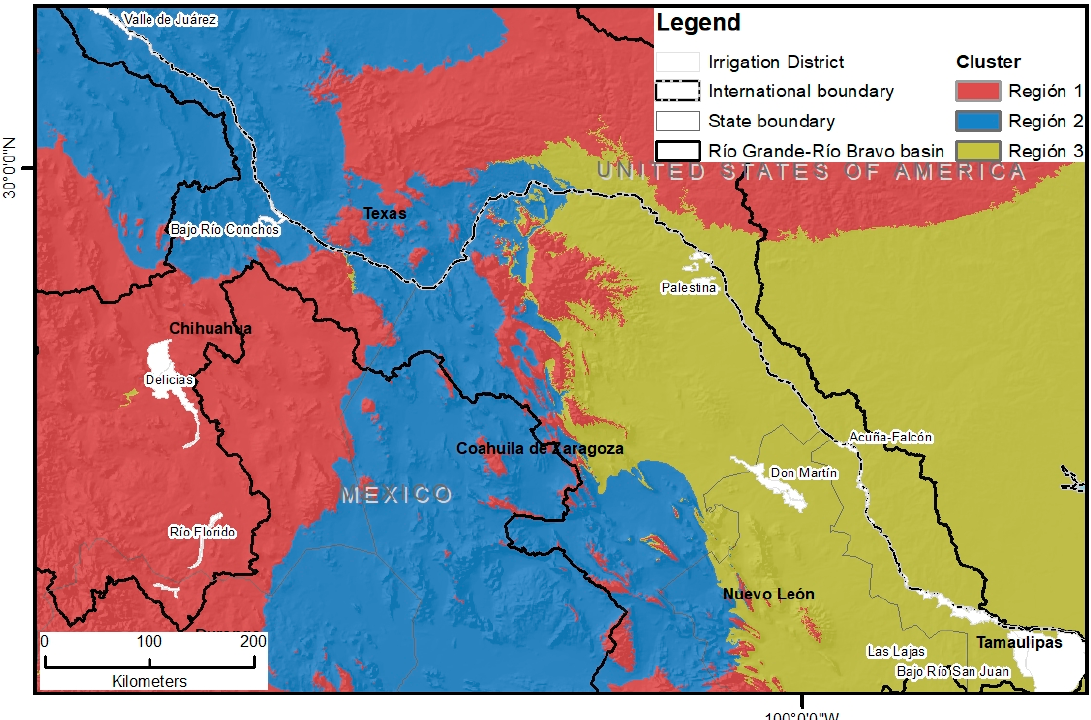
Figure 4. Regions resulting from the cluster analysis.